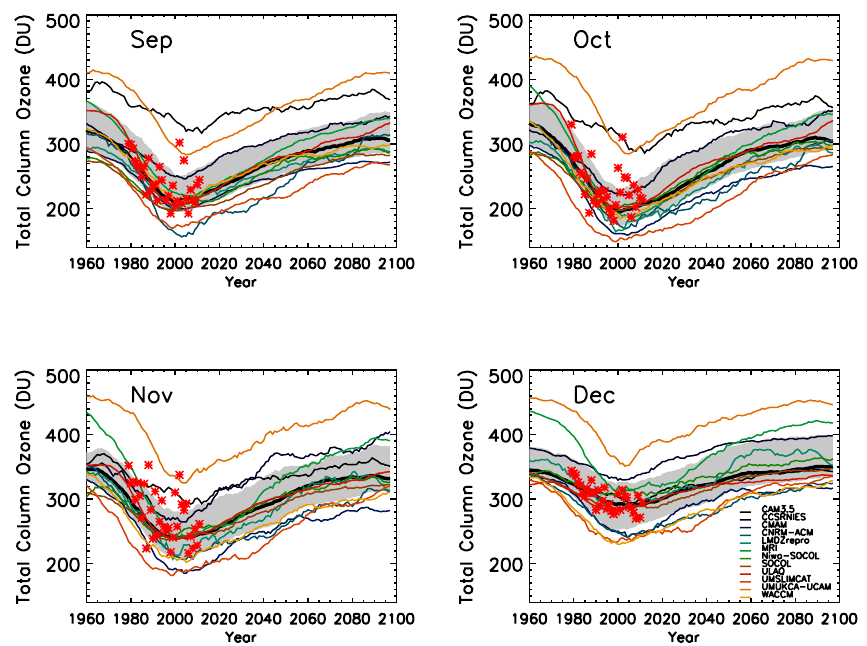
Fig. 1. Total Column Ozone (TOC) time series zonally averaged poleward of 60 ◦ S from selected REF-B2 model simulations as indicated on the bottom right panel. Thick black curve is the multi-model median, grey area represents the 95% confidence limit of the median derived using a bootstrapping method. Data are smoothed with a 15yr uniformly weighted sliding mean filter. Red stars indicate zonally averaged unsmoothed TOC values poleward of 62.5 ◦ S from the TOMS version 8.5 merged ozone dataset (MOD) for